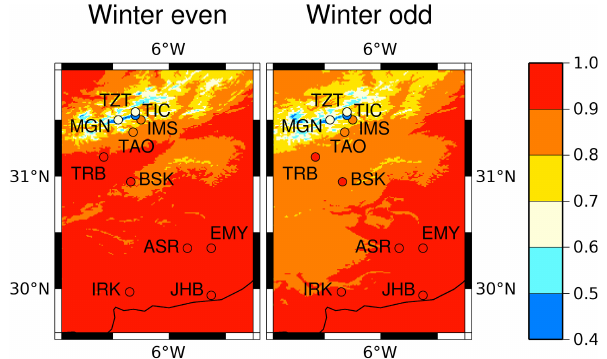
Fig. 9. Estimated probabilities of zero daily precipitation ( p 0 ). First (second) subset consists of all winter values with an even (odd) en- try number. p 0 is interpolated to the grid of the digital elevation model by multiple linear regression. The points at the test sites are coloured according to the original probabilities.